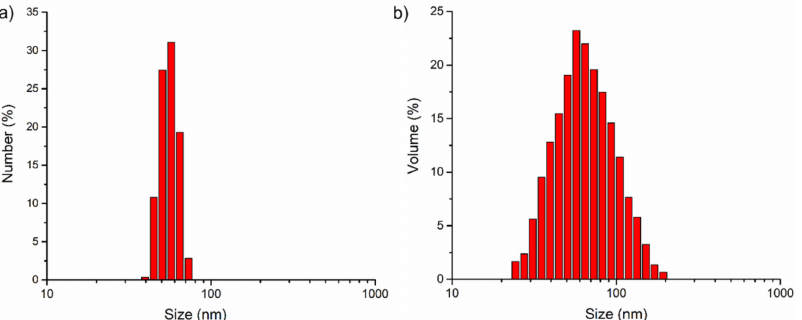
Figure 1. Dynamic light scattering (DLS) measurements of the size dispersion of the HApFe, showing data weighted by the number ( a ) and volume ( b ) of particles,